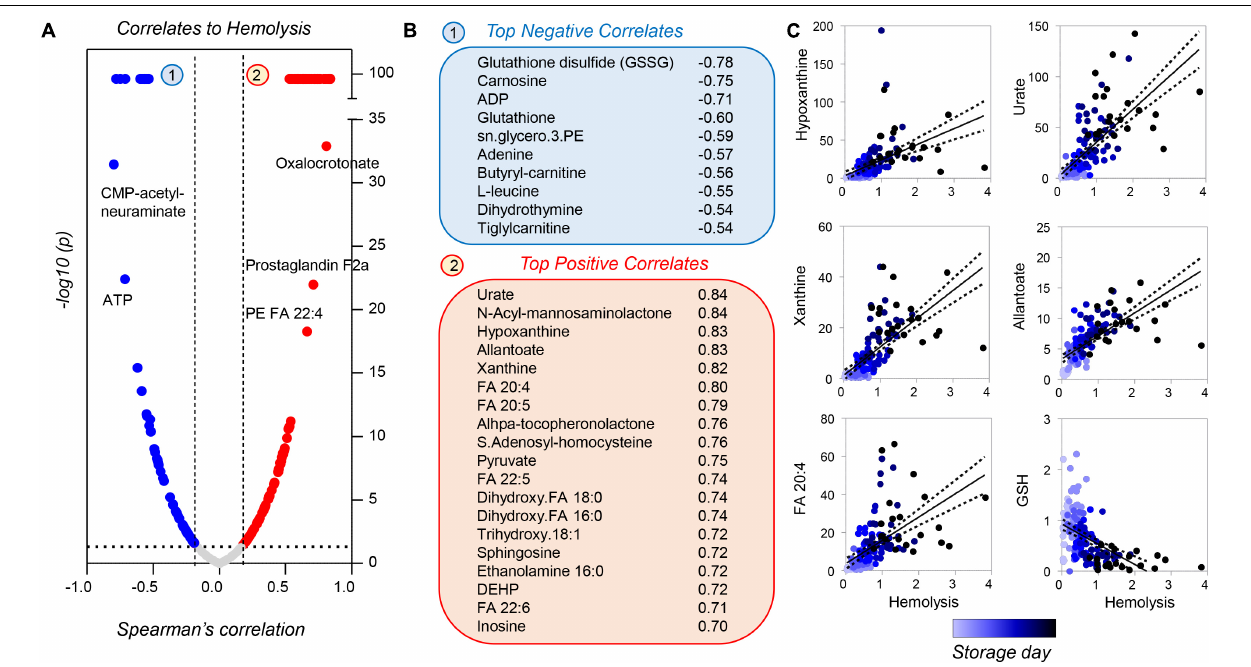
FIGURE 10 | Metabolic correlates to hemolysis for stored guinea pig RBCs. Volcano plots in panel (A) indicate Spearman correlation (x-axis) and significance [–log10( p -value) on the y-axis]. A subset of metabolites was strongly correlated [arbitrary –log10(p) = 99], either negatively (blue) or positively (red) to storage hemolysis (B) . A subset of these metabolites is shown in panel (C) (color coded from light to dark blue as a function of storage